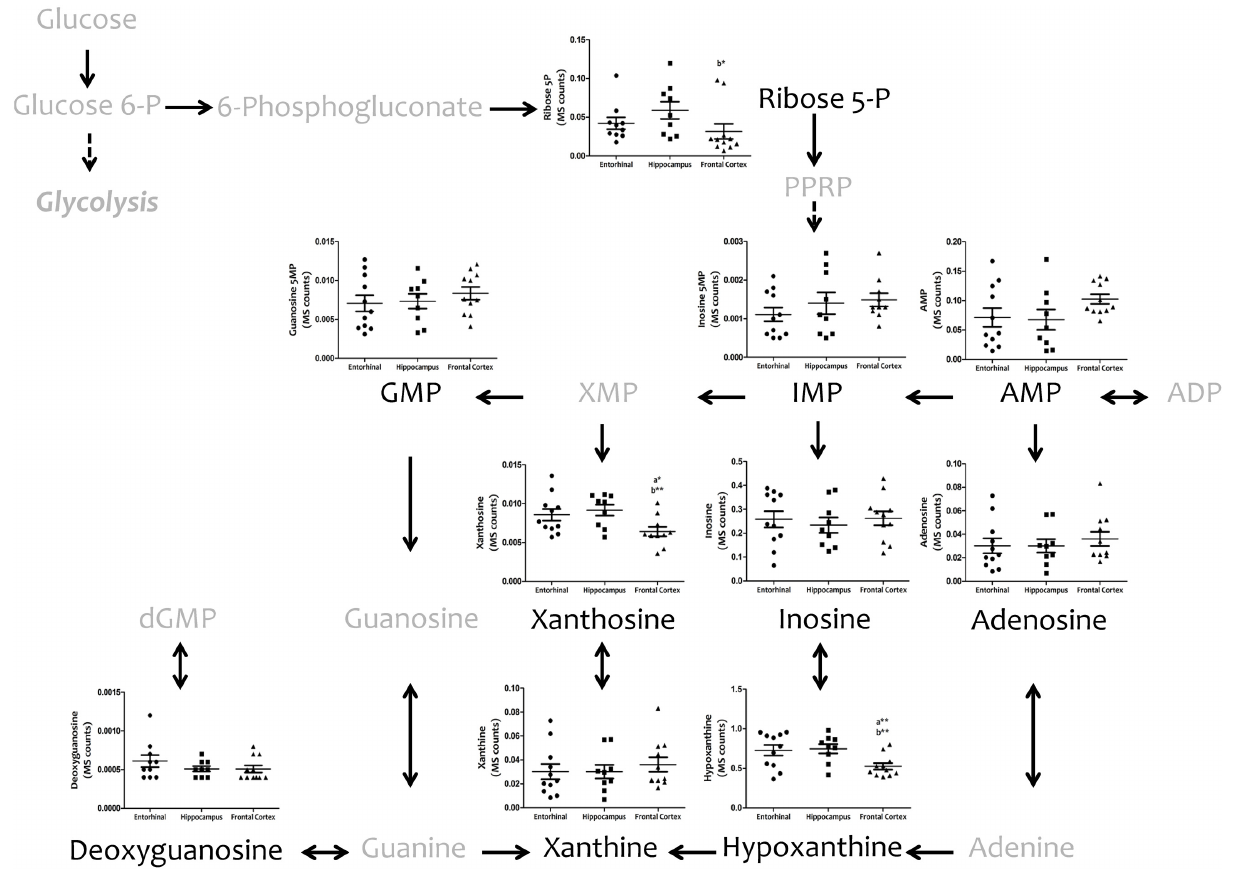
FIGURE 5 | Tissue concentrations of metabolites from the purine metabolism in different regions of the adult human cerebral cortex. All metabolites were measured with TQMS. ∗ p < 0.05; ∗∗ p < 0.01; ∗∗∗ p < 0.001. a, significant differences with respect to entorhinal cortex; b, significant differences with respect to